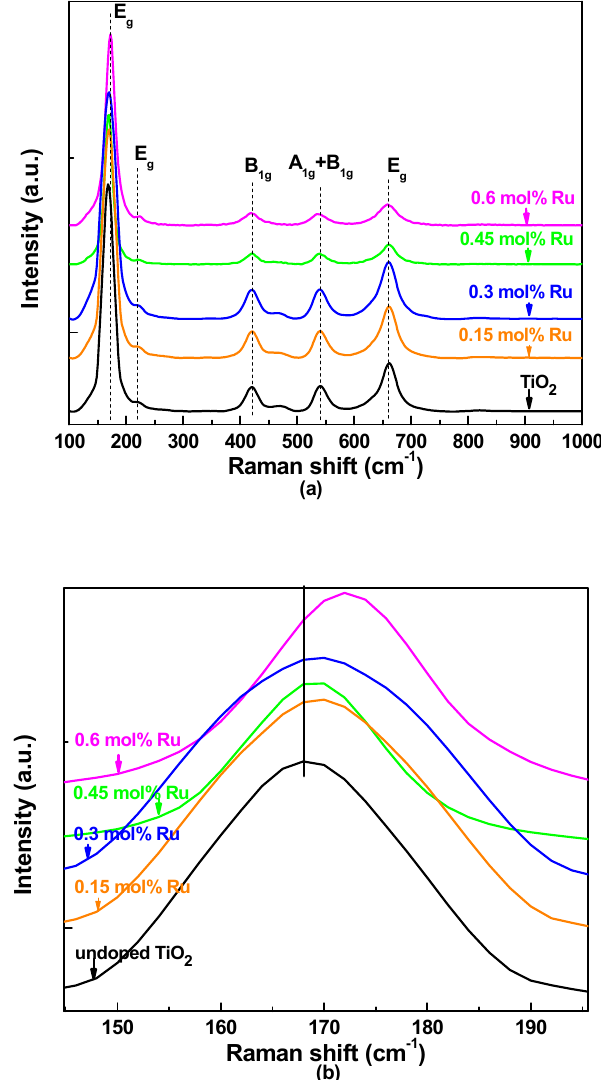
Figure 3. ( a ) Raman spectra of undoped TiO 2 , 0.15, 0.3, 0.45 and 0.6 mol% Ru-doped TiO